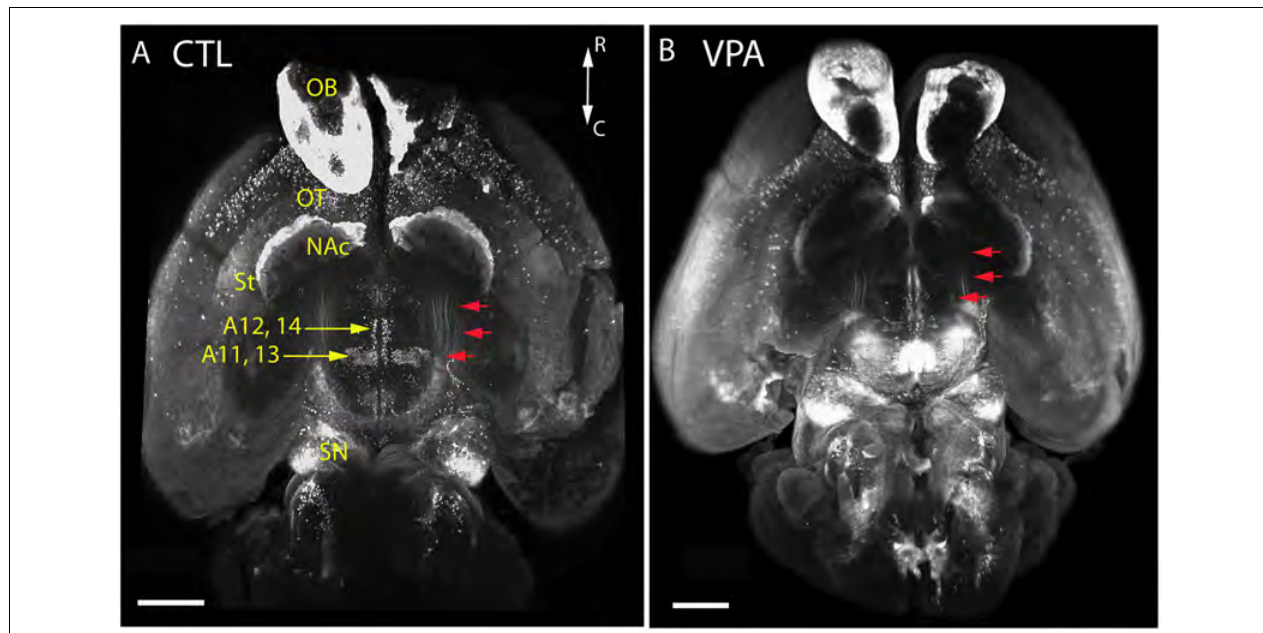
FIGURE 4 | Images of whole-mount P7 mouse brains immunostained against TH, obtained using the iDISCO method of combined immunolabeling and tissue clearing. (A) Control (CTL) mouse born to vehicle-treated mother. (B) VPA-treated (VPA) mouse born to sodium valproate exposed mother. Note the apparent reduction of the volume and density in the mesotelencephalic dopaminergic pathway (red arrows) and the lateral hypothalamic/incertohypothalamic dopaminergic cell groups (A11–13) of the VPA specimen. Scale bar: 1 mm. Other abbreviations: NAc, nucleus accumbens; OB, olfactory bulb; OT, olfactory tubercle; SN, substantia nigra; St, striatum.